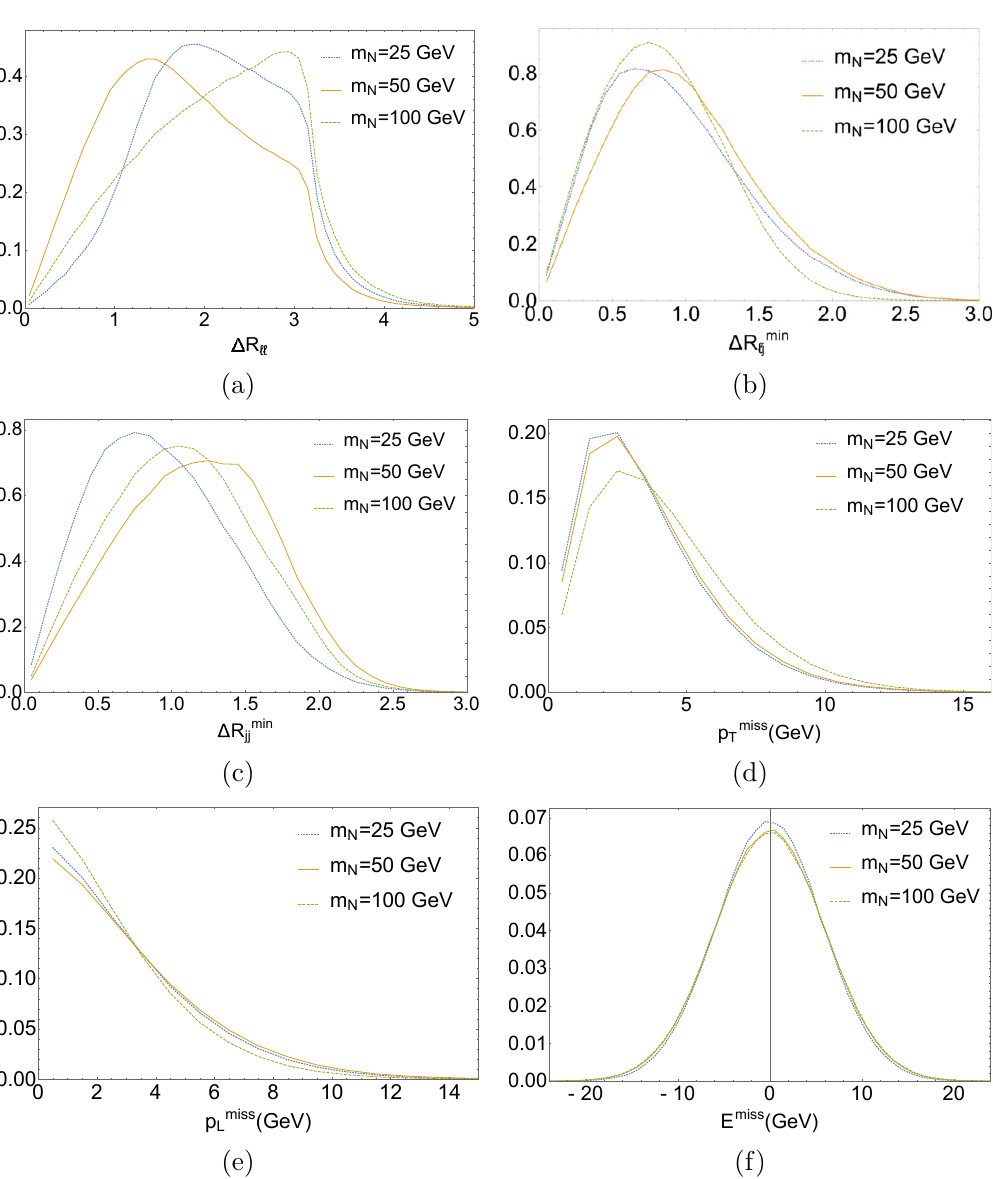
and (c) (cid:1) R min ; jj ‘j and (f) the L